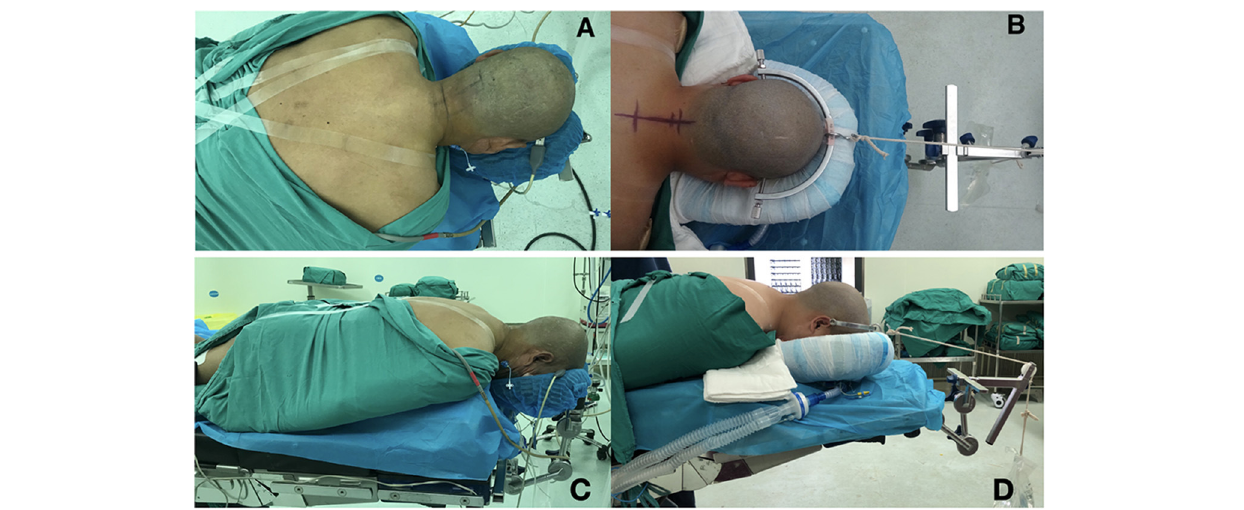
FIGURE 3 | The patients undergoing surgical treatment in the prone position. The patients in the traditional position with a horseshoe headrest (A,C) and in the BSPST position with a cervical tong for skull traction and body-shape plaster bed for fixation (B,D) as seen from a vertical and horizontal angle. The BSPST position can provide enough space for managing the anesthesia tube and reliable intraoperative steadiness with the usage of body-shape plaster bed and skull